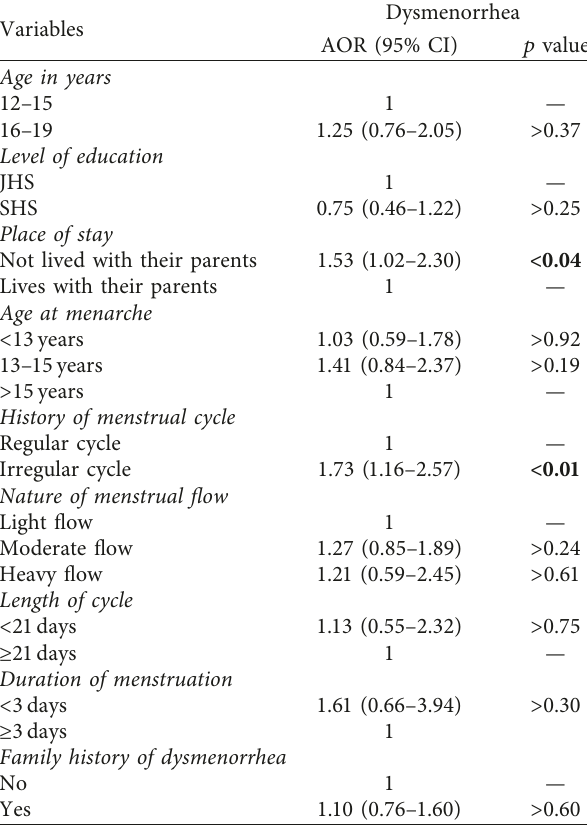
Table 3: Univariate analysis of the effect of dysmenorrhea among the study participants.